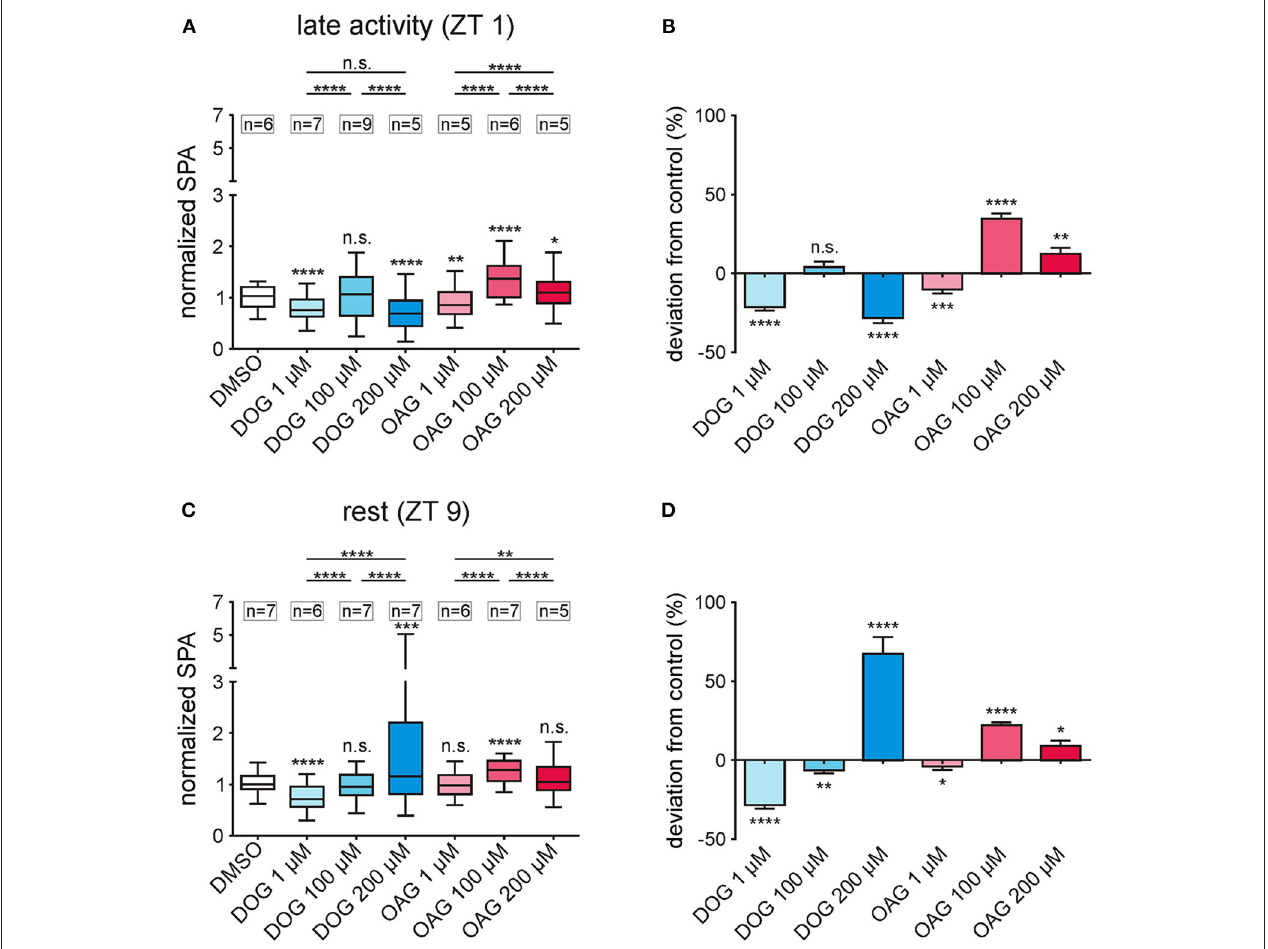
FIGURE 3 | Infusion of different doses of the DAG analogs DOG and OAG showed that both analogs affected different ion channels underlying the bombykal-dependent normalized sensillum potential amplitude (SPA) with different sensitivity. (A,B) 1, 100, and 200 µ M of the DAG-analogs DOG and OAG were applied in tip recordings during the late activity phase (ZT 1). The overall values (A) as well as the percentage changes to the controls (B) show a significant decrease in the normalized SPA in the presence of 1 µ M ( n = 7) or 200 µ M DOG ( n = 5), while 100 µ M DOG ( n = 9) had no effect. Application of 1 µ M OAG reduced the normalized SPA ( n = 5), while 200 µ M OAG ( n = 5) moderately- and 100 µ M OAG more strongly increased it ( n = 6). (C) During rest (ZT 9) the mean values of the normalized SPA were significantly reduced by 1 µ M DOG ( n = 6) and significantly increased by application of 200 µ M DOG ( n = 7) and 100 µ M OAG ( n = 7). All other concentrations showed no significant differences from the controls in their mean values. (D) However, all concentrations applied showed significant differences in the percentage change from the control (for exact P -values see Table 2 ; for mean values ± SEM see S2. n.s. = not significant; * P < 0.05; ** P < 0.01; *** P <